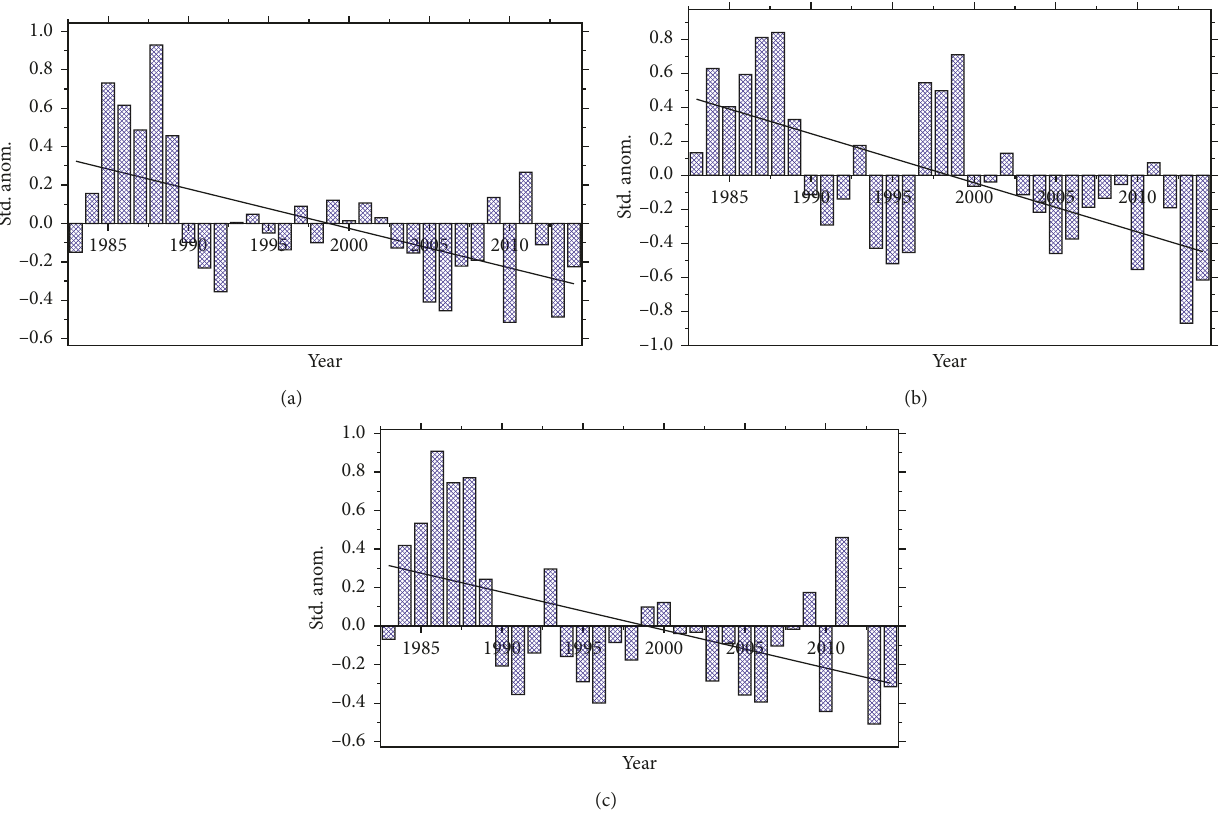
Figure 6: Standardized anomalies of the diurnal temperature range (DTR) over three agroecological zones, (a) lowland, (b) midland, and (c) highland, for the period